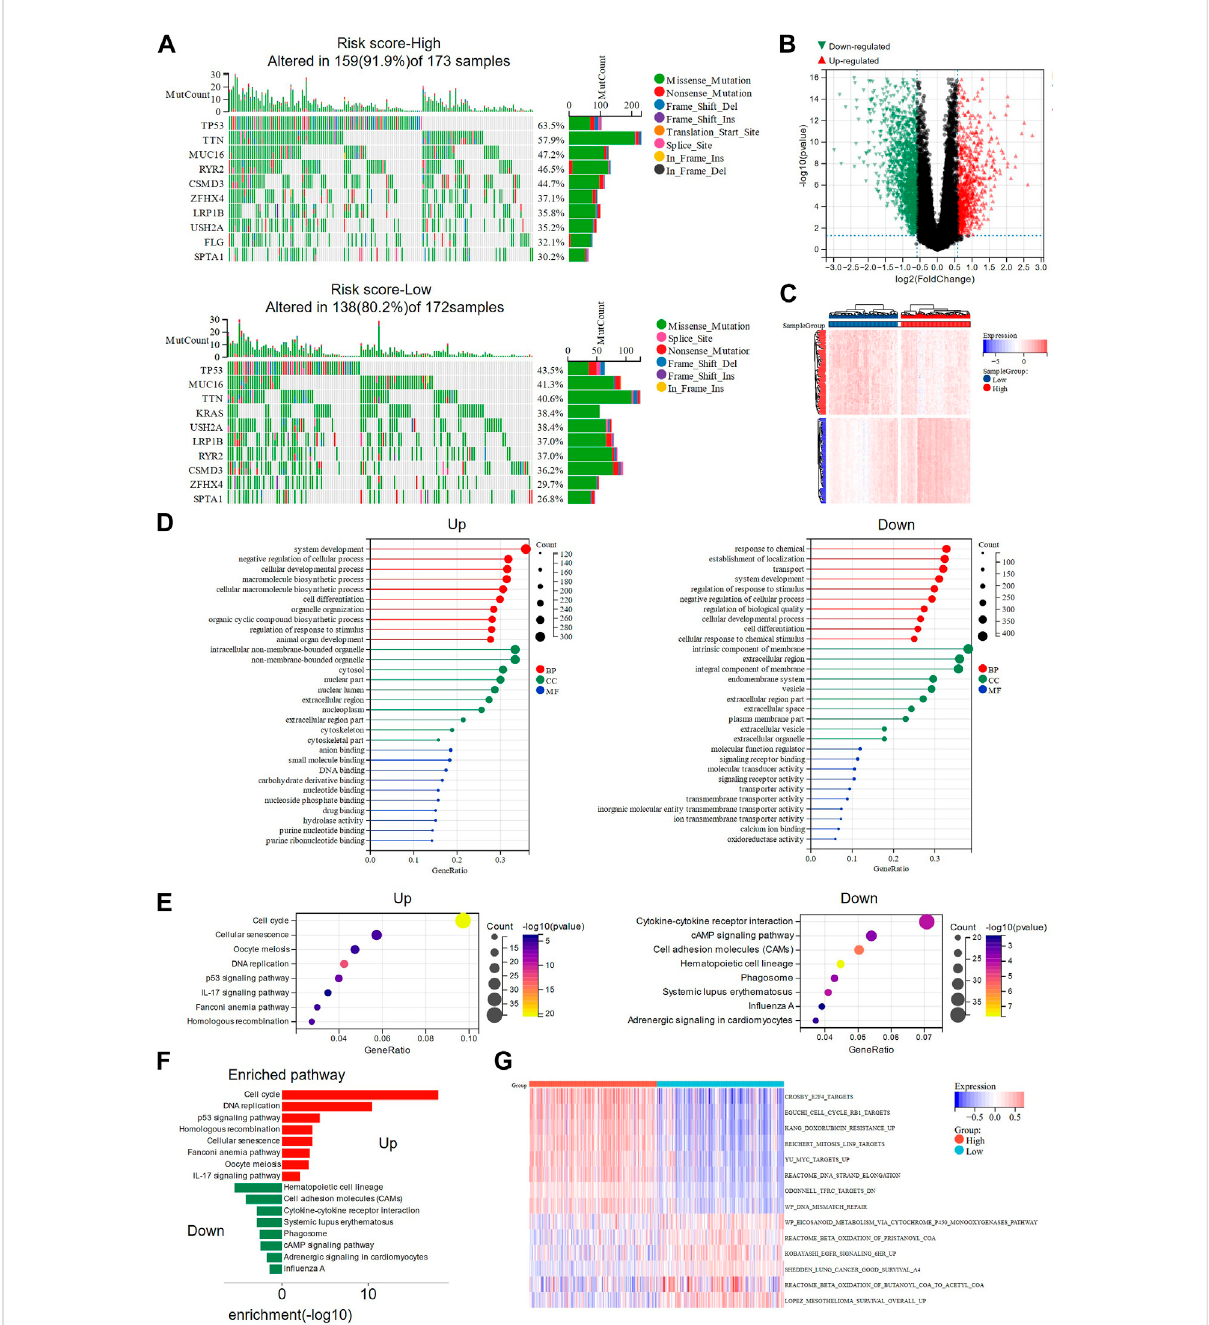
FIGURE 4 Somatic mutation analysis and functional enrichmentanalysis ofDEGs inhigh- andlow-risk groups. (A) The waterfall plots showed thesomatic mutationlandscapeinhighandlowriskgroups. (B) VolcanoplotpresentingtheDEGsscreenedbetweenthehigh-andlow-riskgroups. (C) Theheat map showing the expression of DEGs in high and low-risk groups. (D) GO analysis of up-regulated and down-regulated genes in high-risk group were performed separately. (E,F) KEGG analysis revealed the main pathways involved in DEGs. (G) Pathway activities in high- and low-risk groupswereanalyzedusingGSVA.DEGs:differentiallyexpressedgenes;GO:GeneOntology;KEGG:GenesandGenomes;GSVA:Genesetvariation